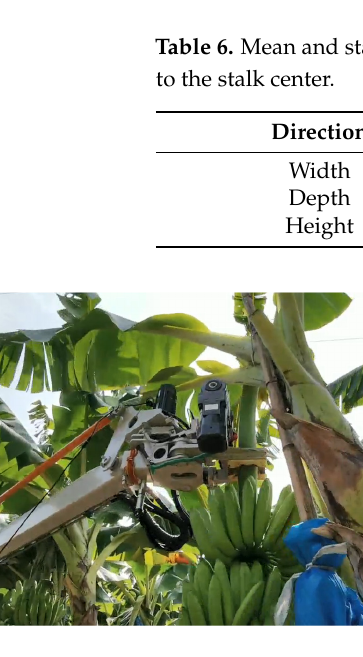
Figure 10. Field experiment scenario.